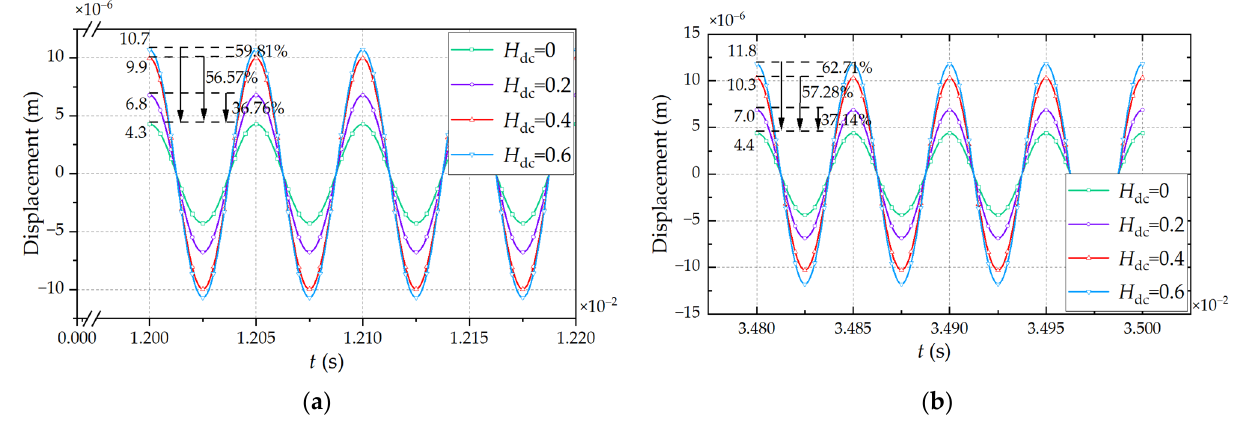
Figure 13. Iron core deformation characteristics. ( a ) Interleaved windings; ( b ) Continuous windings.